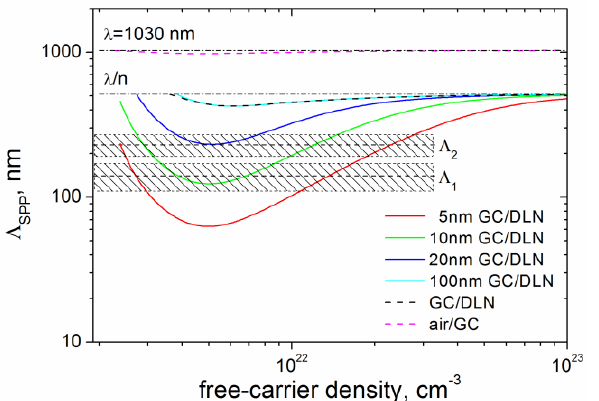
Figure 10. Period of SPP modes vs. free-carrier density, calculated using Equation (6) for different thicknesses of the laser-excited GC layer (5, 10, 20, and 100 nm); for comparison, the Λ SPP data calculated for the interfaces air/GC and GC/DLN using Equation (7) are shown by dashed lines; the Λ 1 (140 ± 30 nm) and Λ 2 (230 ± 40 nm) regions mark the experimental periods of LIPSS from Figures 6 and 7; dash-dot lines mark the light wavelengths in air and DLN film ( n =